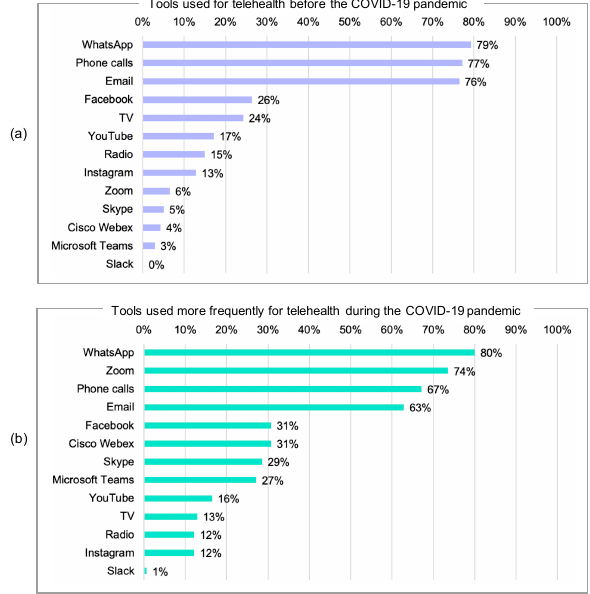
Figure 3. ( a ) Tools used for telehealth before the COVID-19 pandemic; ( b ) tools used more frequently for telehealth during the COVID-19 pandemic.